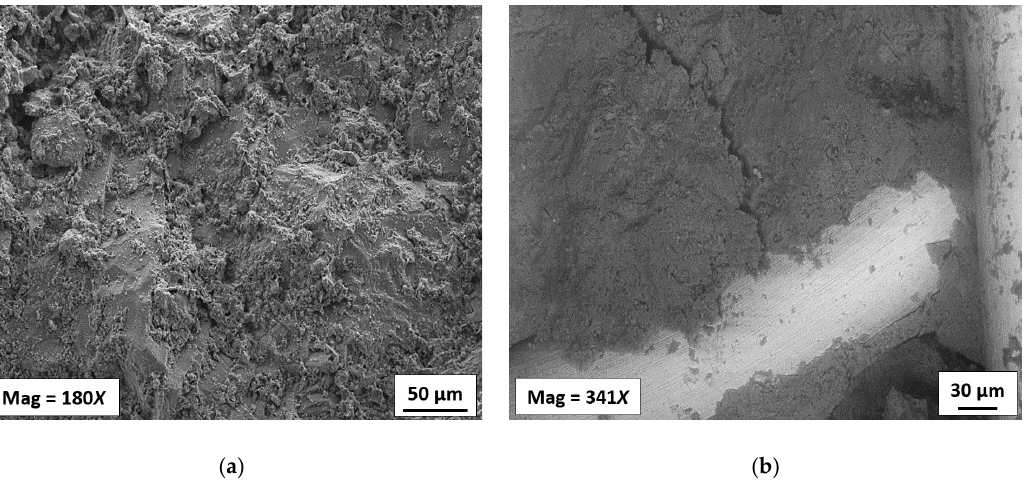
Figure 14. SEM images for specimens exposed to ASR conditions at 56 days: ( a ) specimen with 30% of CA; ( b ) specimen with 10% of CA and 1% SF.